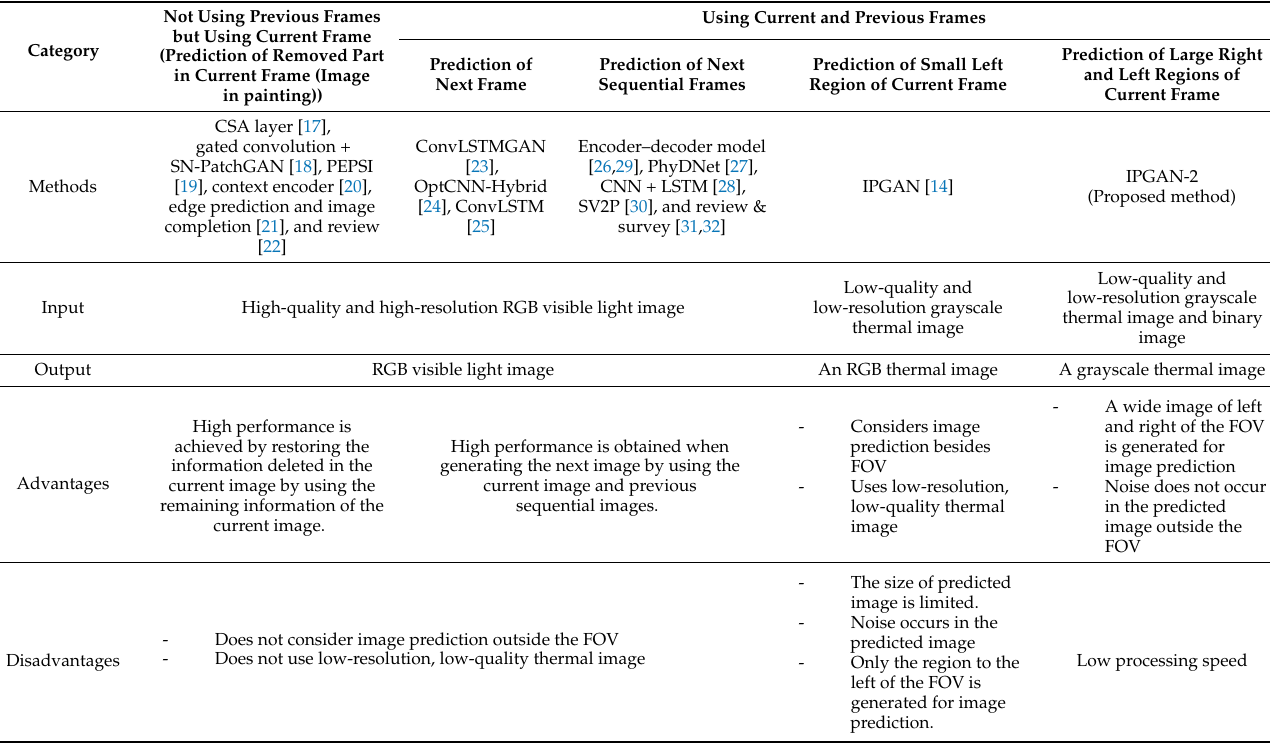
Table 1. Summaries of comparisons between the proposed method and previous image prediction